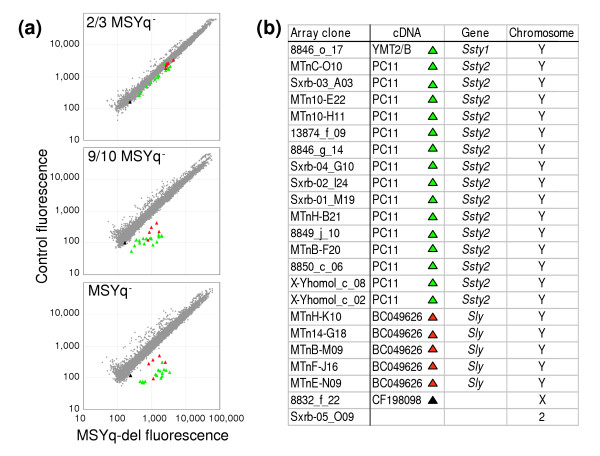
Microarray analysis of the testis transcriptomes of the three MSYq deficient models. (a) Scatter plots showing transcription levels for the testis transcripts of MSYq deficient models relative to their controls. Expression in the MSYq deficient mice (y-axis, Cy3 label, arbitrary units) for each clone is plotted versus expression in age- and strain-matched normal testis control (x-axis, Cy5 label, arbitrary units). Data from four technical replicates are combined. Data are normalized on the median signal for each channel and then filtered (as described in Materials and methods) to show only clones with data for two technical replicates from each model. The data points showing significant reduction are plotted as enlarged triangles (Y clones green or red, and one X clone black - for clone identities see b). (b) The 23 cDNA clones identifying transcripts that were significantly reduced in one or more of the MSYq deficient models. The clones deriving from the two Y families and the one X family are color coded.